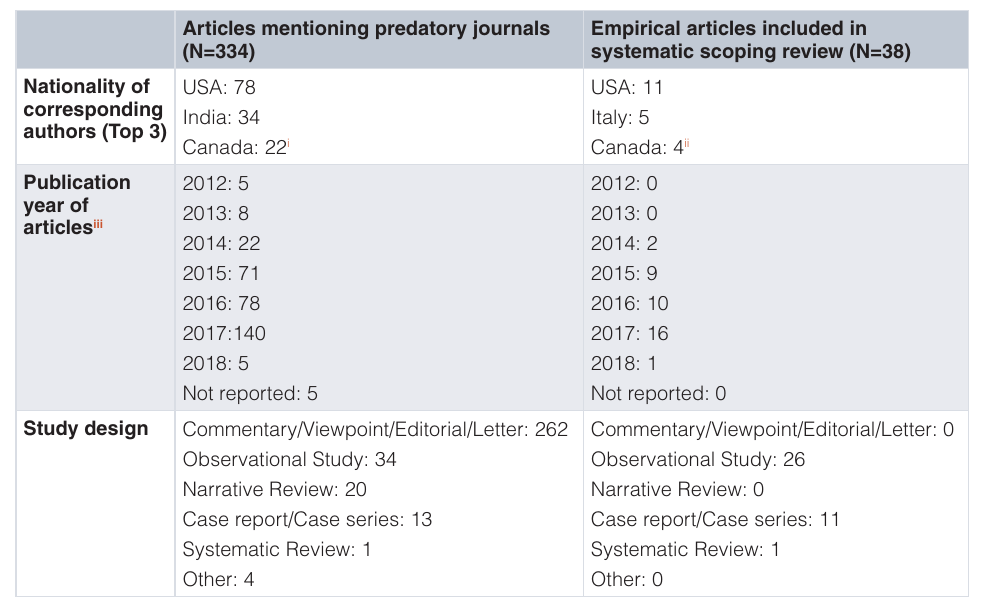
Table 1. Epidemiological characteristics of all articles mentioning predatory journals and those included empirical articles describing empirically derived characteristics of predatory journals included in our scoping